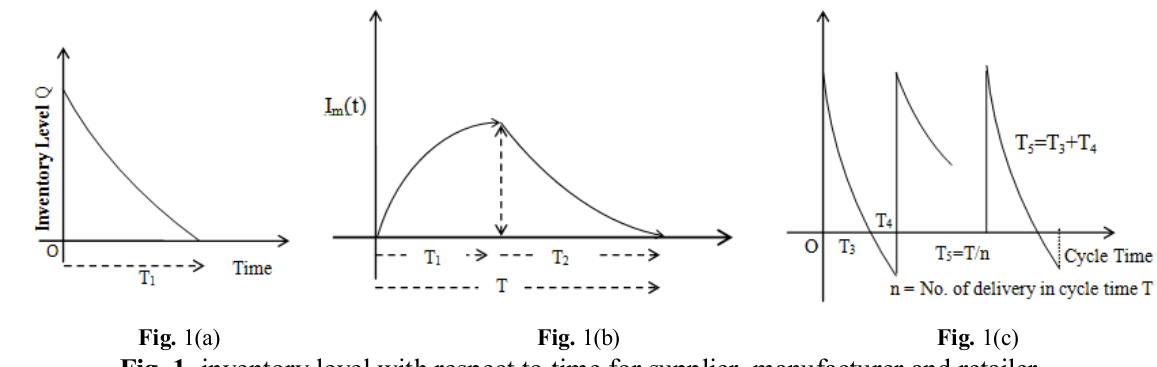
Fig. 1. inventory level with respect to time for supplier, manufacturer and